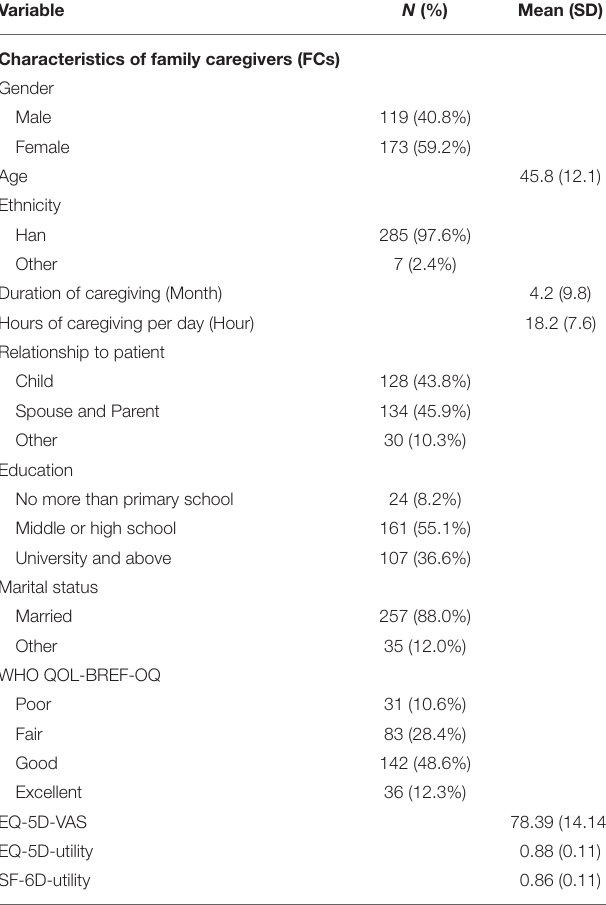
TABLE 1 | Participant characteristics and